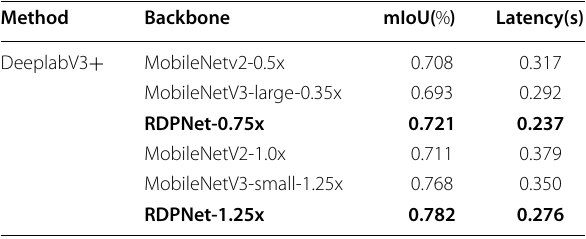
Table 7 Semantic segmentation experiments on the PASCAL2012 dataset Method